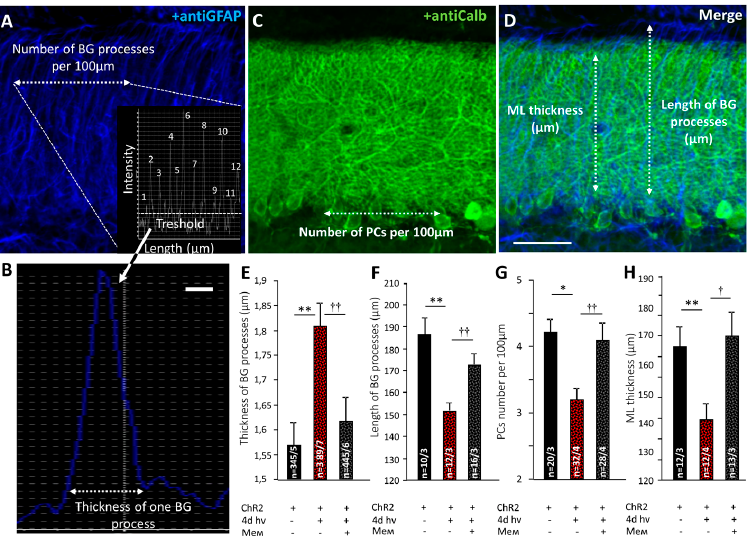
Figure 3. Memantine prevents the pathological transformation of BG and PCs caused by optogenetic hyperactivation of BG. Confocal images of cerebellar cortex labeled with anti-GFAP (glial marker) ( A ), anti-Calbindin (PCs marker) ( C ). The intensity profile of an anti-GFAP signal shows the number of peaks that mark the processes of BG ( A insert). Such an approach leads to estimate the length of a single BG process ( B ). Scale bar 1 µ m. The number of PCs was counted across the 100 µ m line of PCL ( C ). BG processes were longer than the thickness of ML. These data were measures separately ( D ). Scale bar 50 µ m. ( E )—Averaged thickness of BG processes. ( F ) Averaged length of BG processes. ( G )—Averaged number of PCs per 100 µ m of PCL. ( H )—Graph shows ML